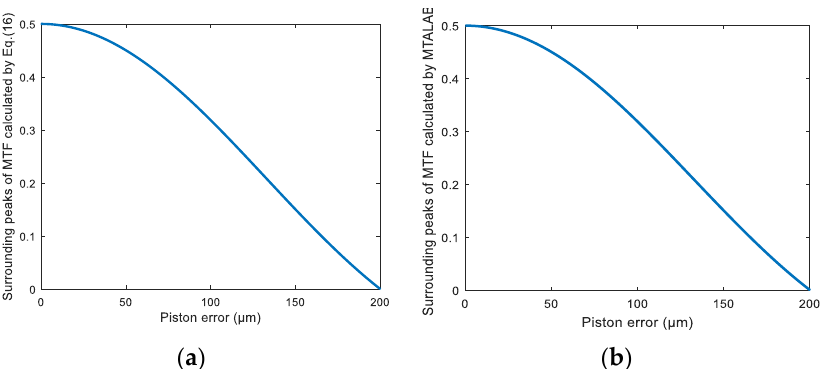
Figure 3. Surrounding peak heights of MTF varying with the piston error ( a ) calculated by Equation (16) and ( b ) obtained by the MATLAB program.